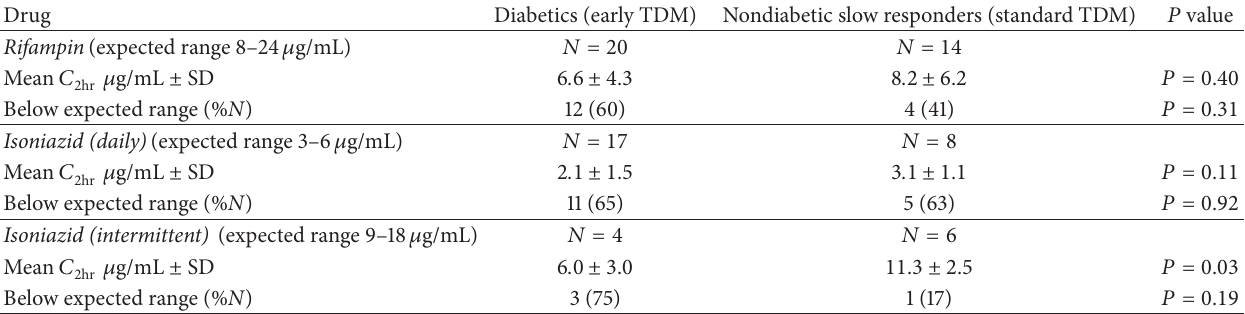
) for isoniazid and 2hr